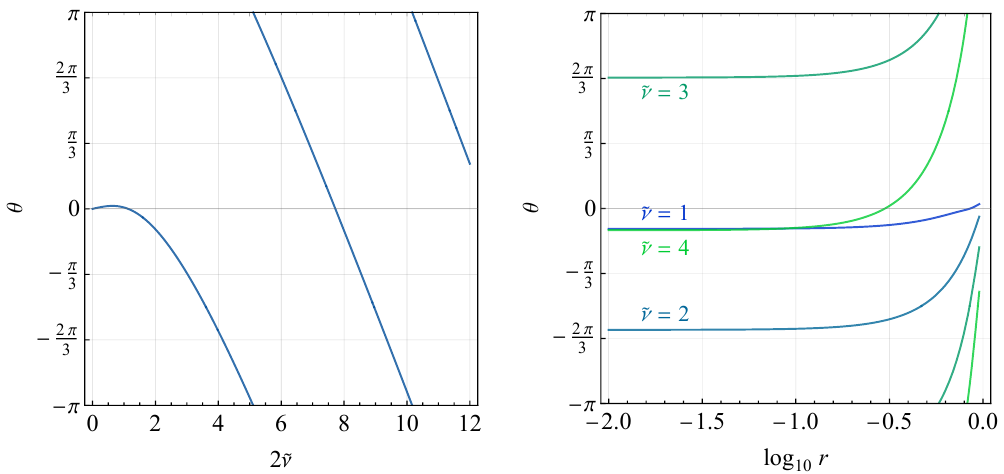
Figure 8 . The phases θ T ( r, r ) of the nonlocal signal from the s -channel 1-loop exchange of a massive scalar. The left panel shows the phase in the squeezed limit r → 0 as a function of oscillation frequency ω = 2 ν , for time-derivative coupling. The right panel shows the phases from e time-derivative coupling as functions of momentum ratio r , for several values of